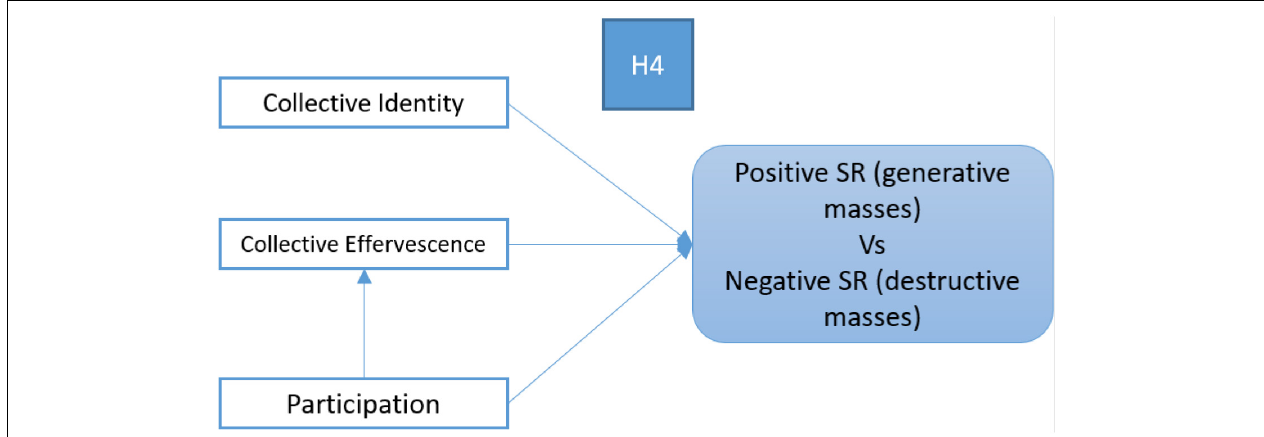
FIGURE 1 | Behavioral (participation), socioemotional predictors (collective effervescence), and socioemotional variables as positive predictors of generative and benevolent Social Representations of Masses and negative predictors of barbarian Social Representations of